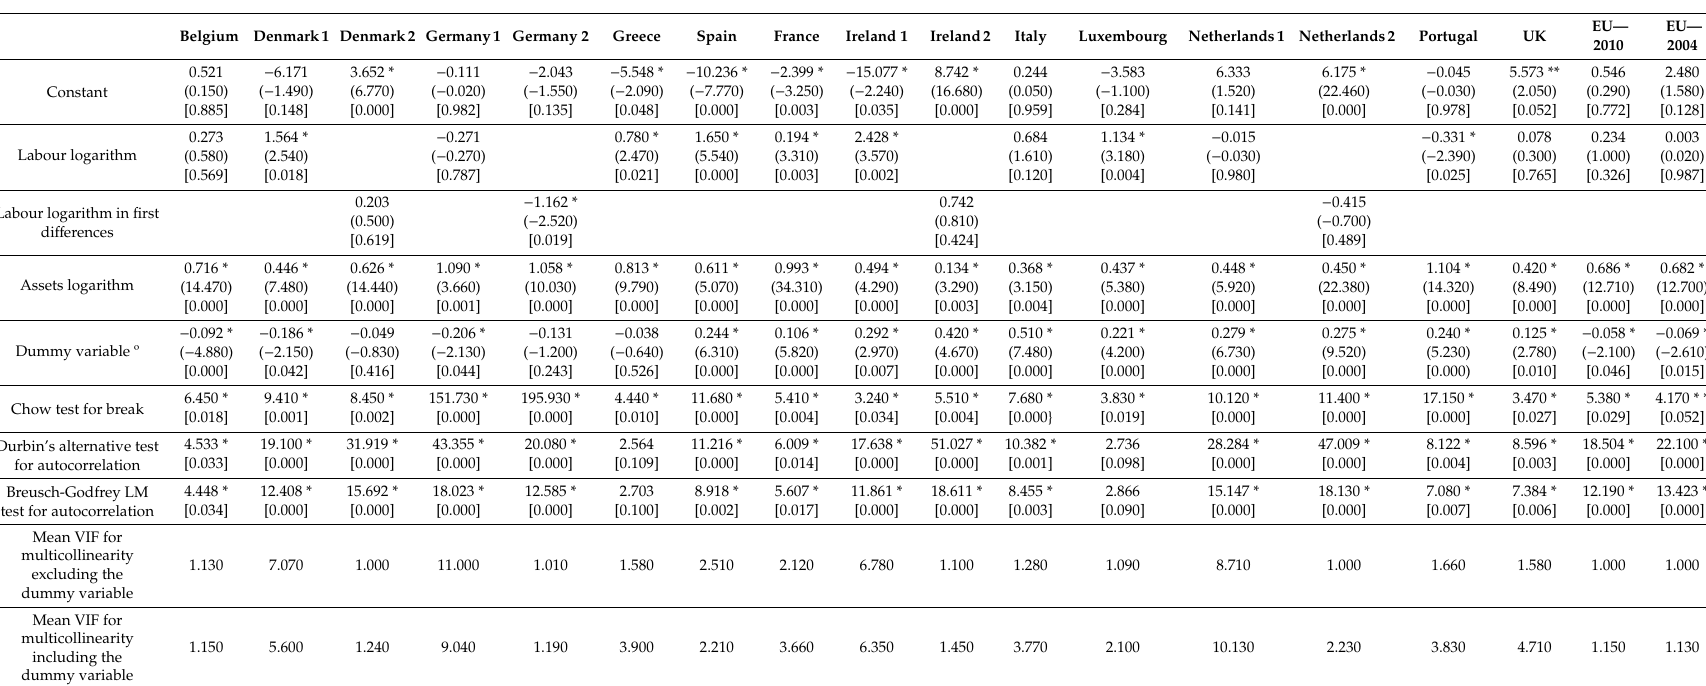
Table 1. Results for time series estimations with Newey-West standard errors, based on the Cobb-Douglas model (Output logarithm as dependent variable), over